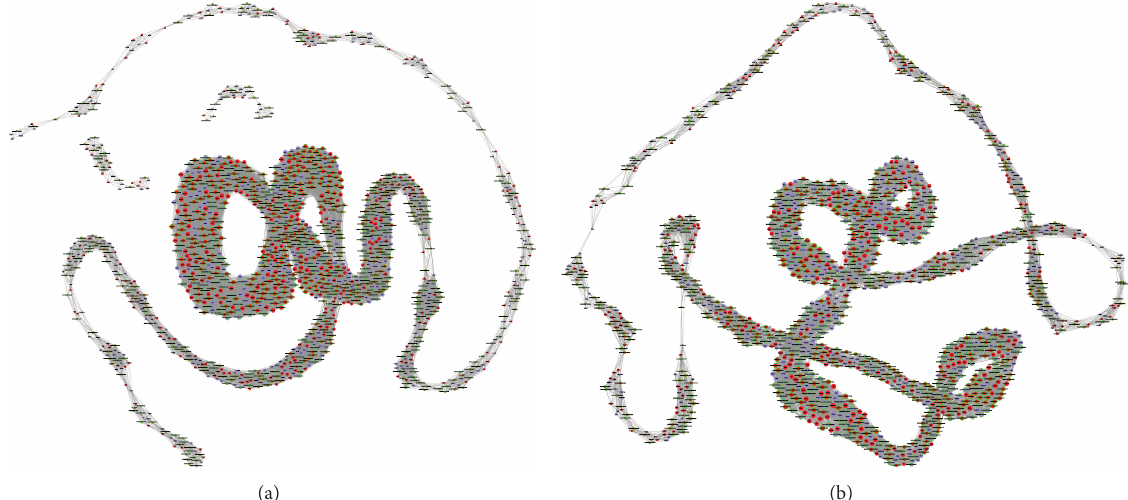
Figure 6: The lncRNA-mRNA coexpression network. (a) The lncRNA-mRNA network containing the 625 filtered mRNAs and 723 filtered aberrant expressed lncRNAs in cytokine stimulation group. (b) The lncRNA-mRNA network containing the 625 filtered mRNAs and 723 filtered aberrant expressed lncRNAs in control group. Upregulated RNAs are shown in red, and downregulated RNAs are presented in purple. Nodes without a ring represent mRNAs, nodes with a ring represent lncRNAs, and node size represents the degree of centrality.